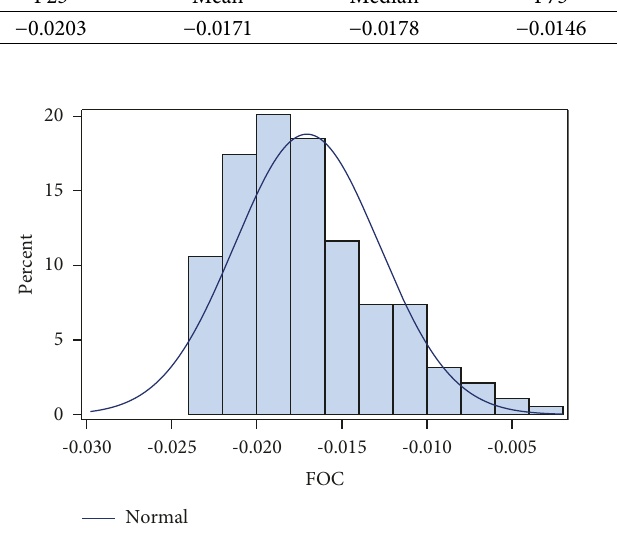
Figure 1: Histogram of the first-order condition test. Table 8: Difference in premiums and overbidding between SOEs and